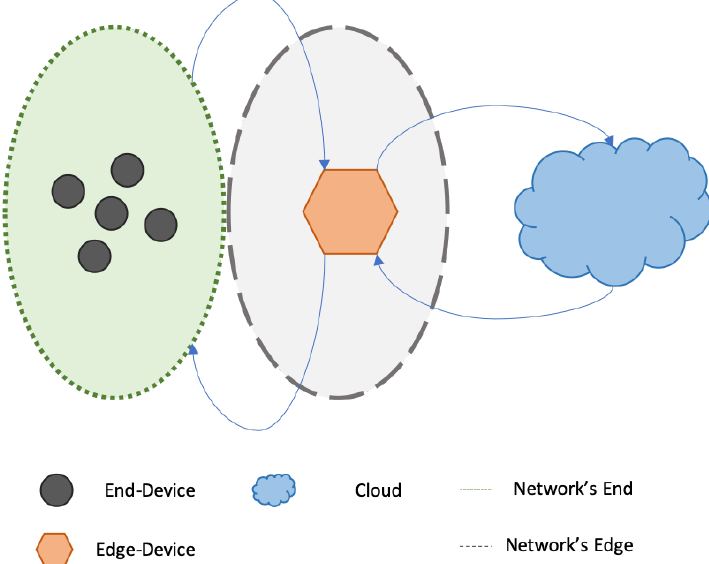
Figure 1. Standard Internet of Things (IoT) network architecture depiction. The network has many boundaries, the Cloud, the edge, and the environment/end. The end-devices are responsible for acquiring the environmental data; send the data to the edge-device, which will be forward the data to the Cloud. The Cloud can then send a response to the edge and the end-device. Other architectures can be set, but, this is the architecture used in the scope of this